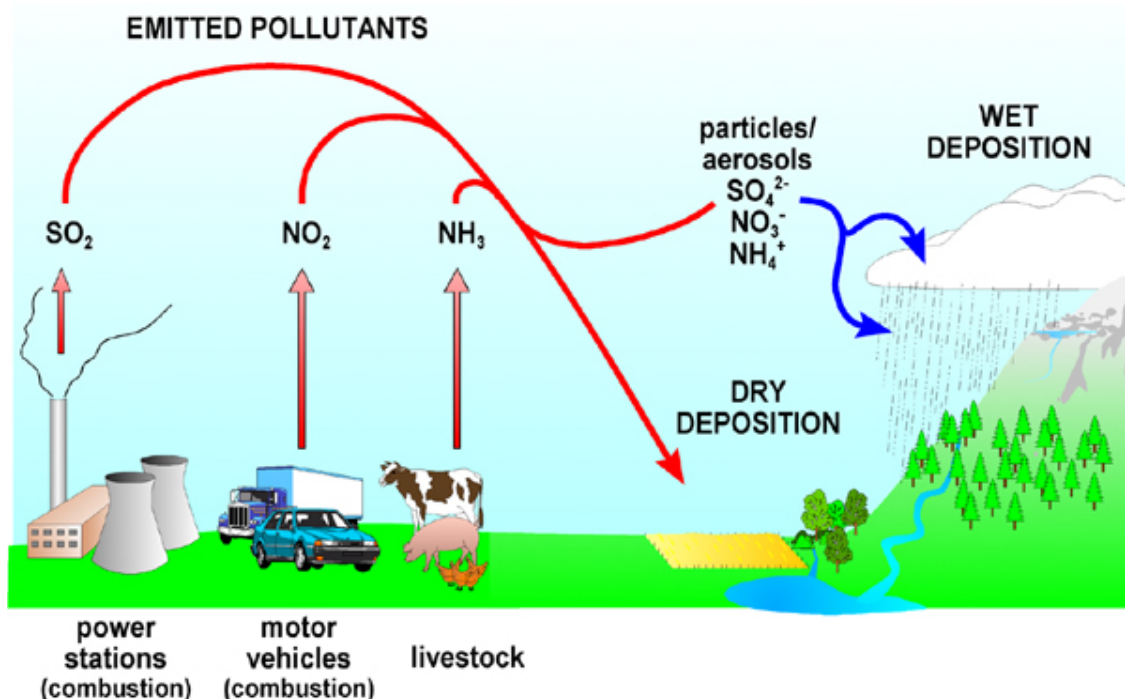
FIGURE 1. Schematic of the major sources and pathways of NH 3 , SO 2 , and NO x in the atmosphere (after